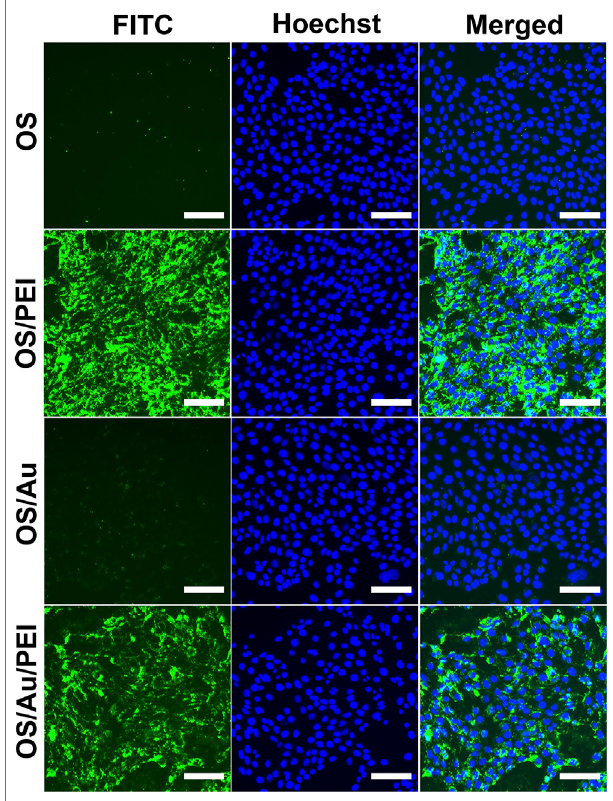
FIGURE2| Fluorescencemicroscopicobservationofthecellularuptake of NPs. The cells treated with OS, OS/PEI, OS/Au, and OS/Au/PEI were observed by fl uorescence microscopy. Scale bar = 100 μ